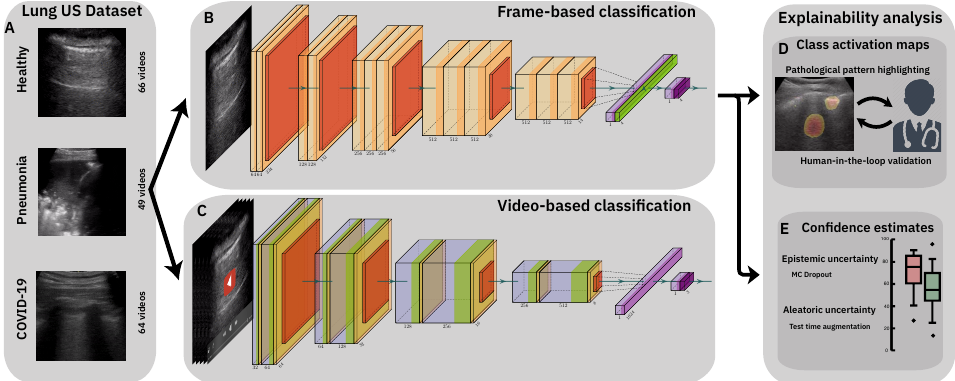
Figure 1. Flowchart of our contribution. ( A ): 3 samples from our public COVID-19 lung US dataset. Top : Healthy lung with horizontal A-lines, Middle : pneumonia infected lung with alveolar consoli- dations, Bottom : SARS-CoV-2 infected lung with subpleural consolidation and a focal B-line. ( B , C ): We present and compare frame- and video-based CNNs on this new dataset and demonstrate the feasibility of differential diagnosis from ultrasound. ( D ): Class activation maps highlight patterns that drove the model’s decision and are reviewed and evaluated for diagnostic value by medical experts. ( E ): Uncertainty techniques are employed and shown to equip the model with the ability to recognize samples with high error